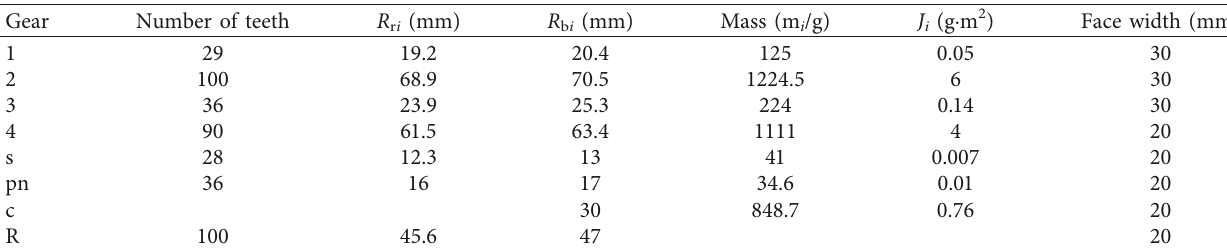
� e � a1 a2 Table 1: Gear parameters.